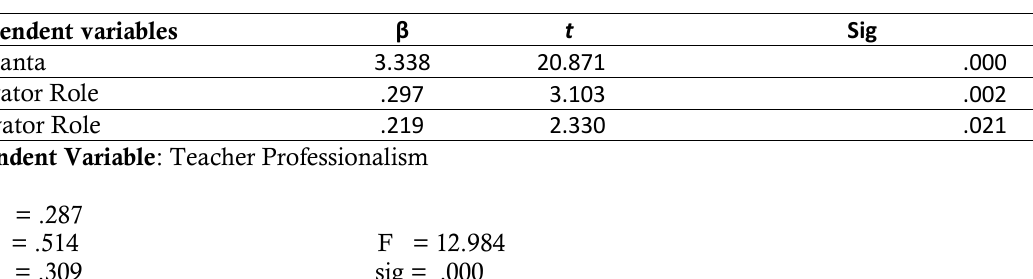
Table 1: Regression Analysis